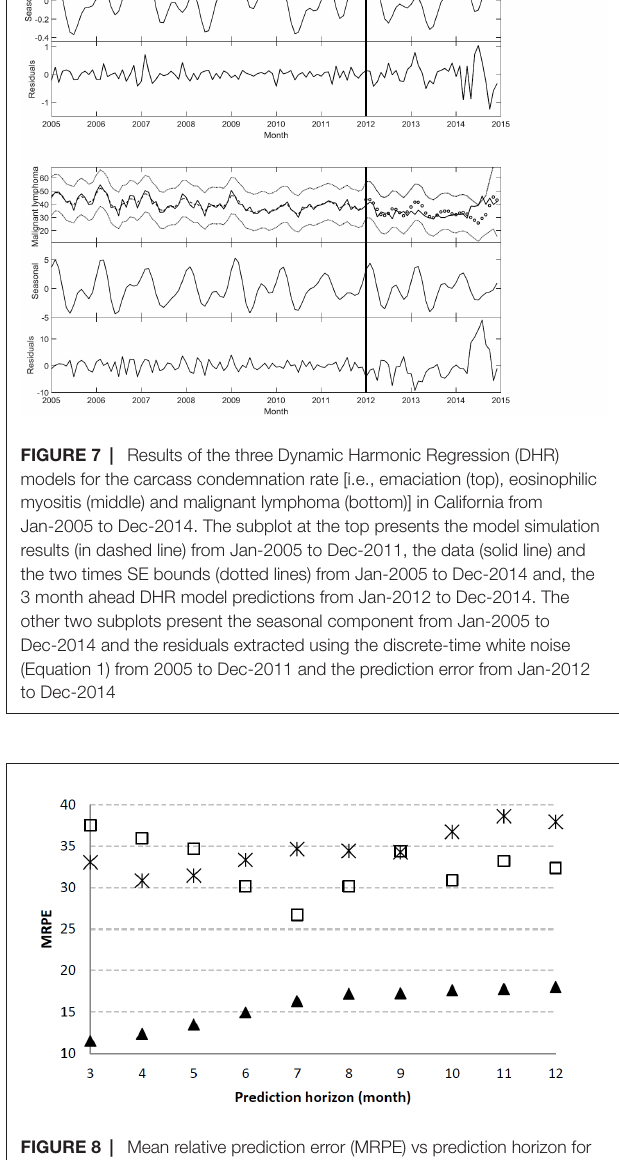
FigUre 8 | Mean relative prediction error (MRPE) vs prediction horizon for the rate of carcass condemnations of emaciation (star), eosinophilic myositis (square) and malignant lymphoma (triangle) in California. The smaller MRPE indicates a closer fit of the model to the